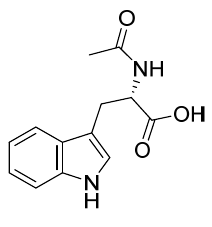
Figure 15. GABA receptor ligands.